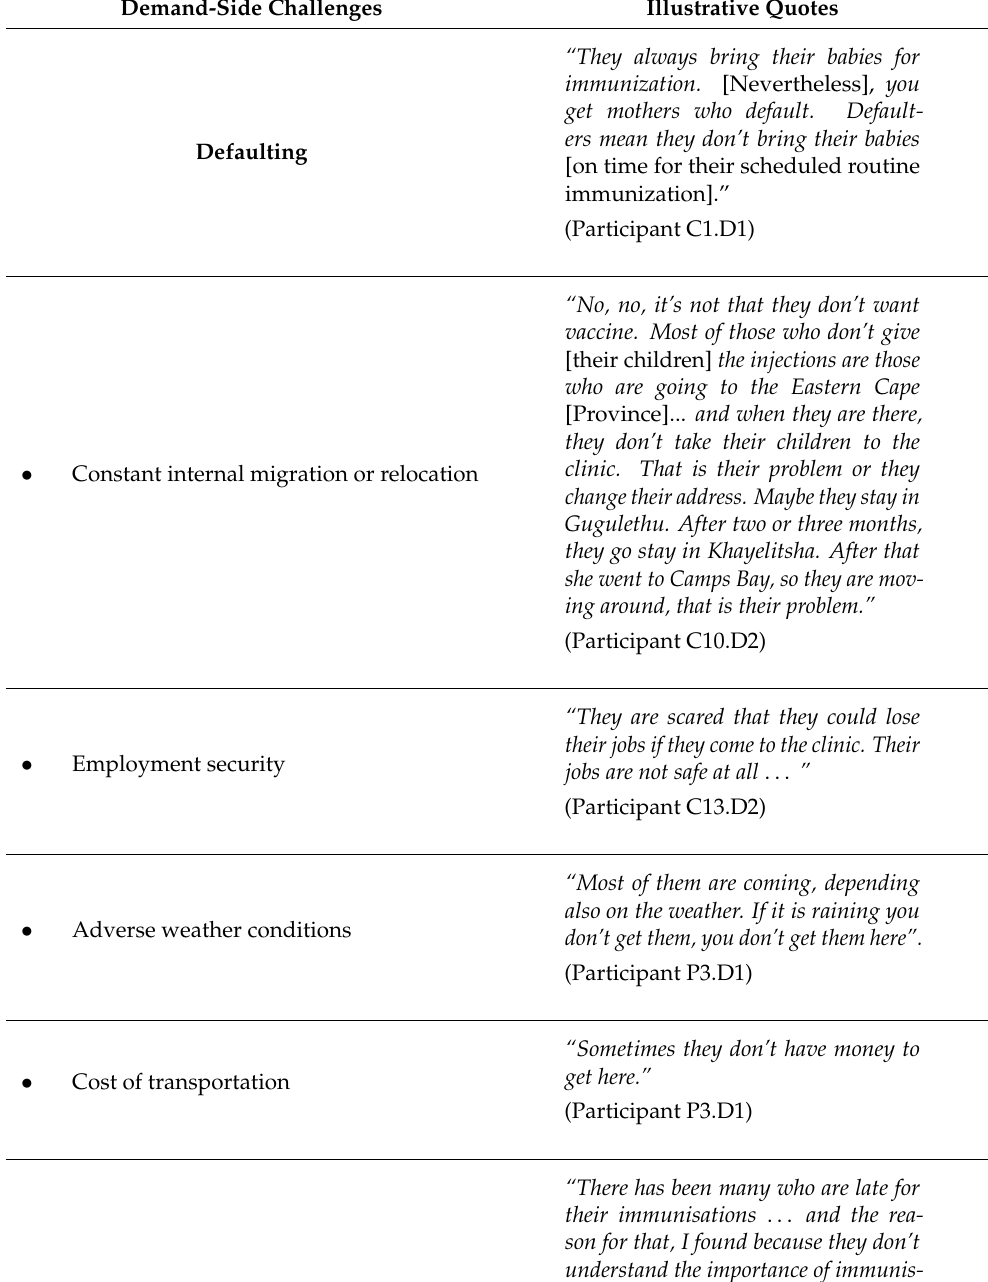
Table 1. Challenges to achieving optimal vaccination